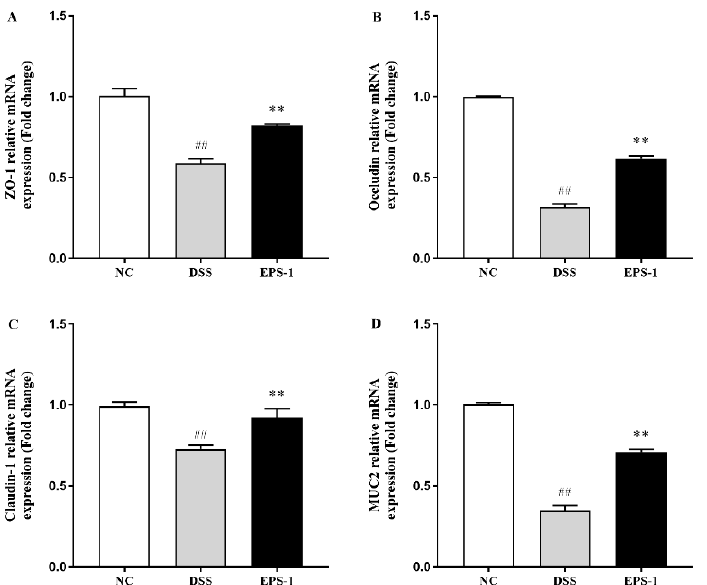
Figure 4. Effect of EPS-1 administration on intestinal barrier-related gene expression of colonic tissues. ( A ) ZO-1, ( B ) Occludin, ( C ) Claudin-1, and ( D ) MUC2. Data are presented as mean ± SD. ## p < 0.01 vs. the NC group, ** p < 0.01 vs. the DSS group by using one-way analysis of variance, followed by Duncan’s test.